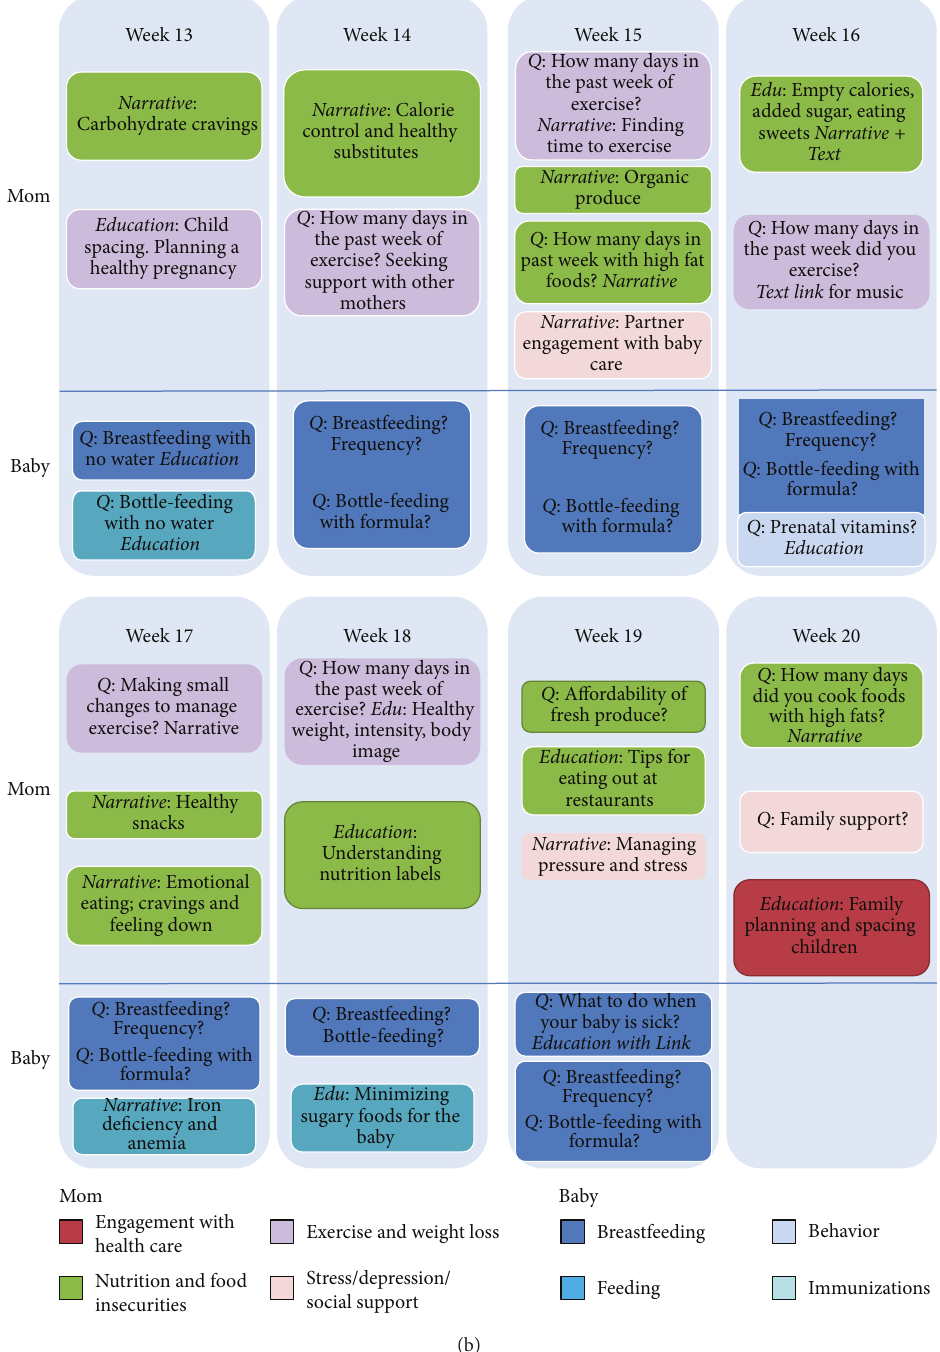
Figure 1: STAR MAMA HIT automated telephone messages content and mode of delivery: Maternal and Child Information (Edu), Queries (Q), Narrative, or